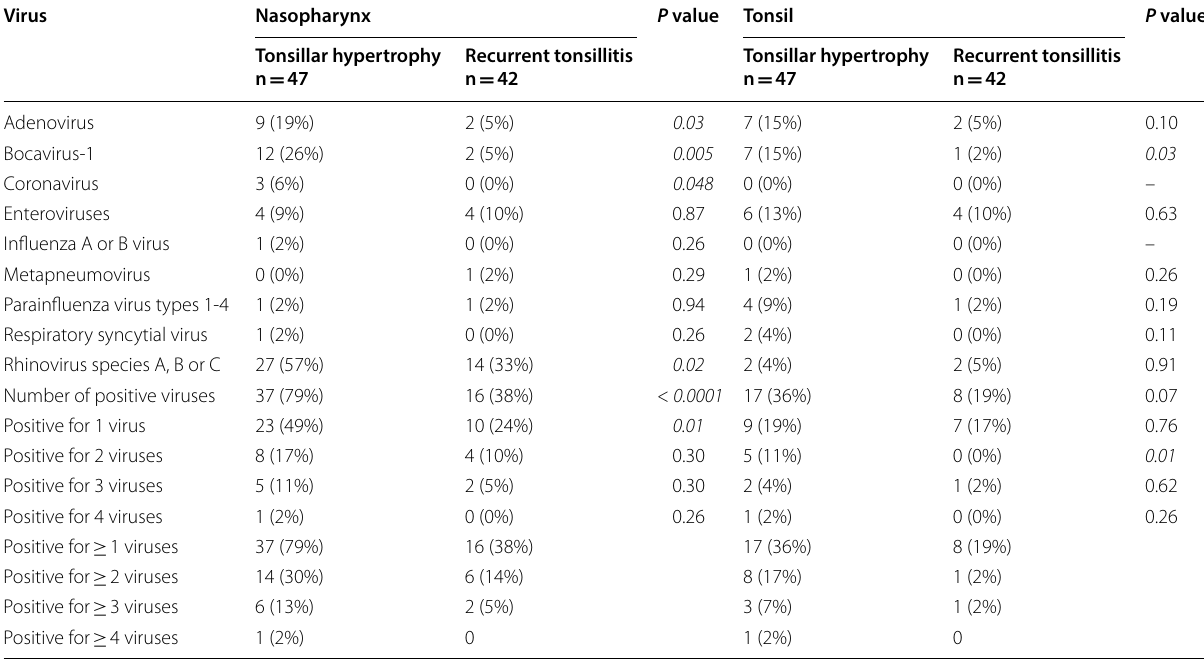
Table 2 Nasopharyngeal and intratonsillar virus detection